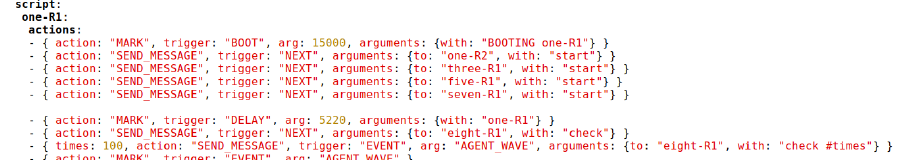
Figure 8. An example yaml script for an agent. Simpler names are used instead of